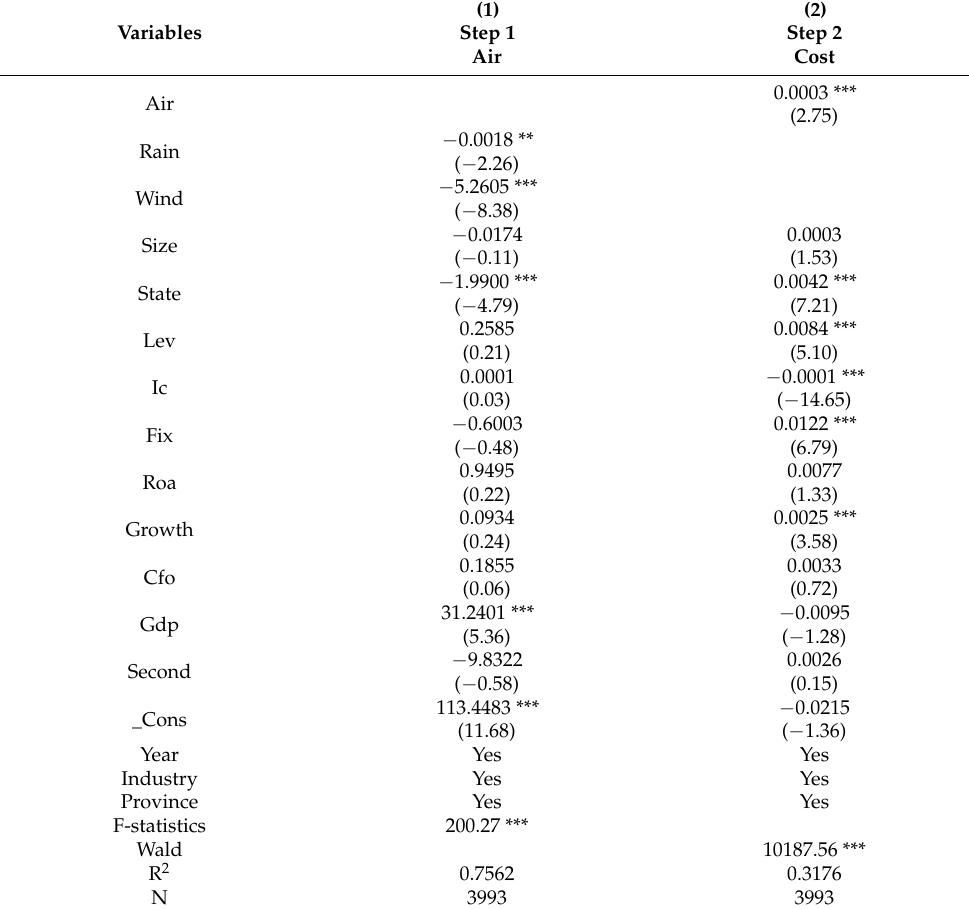
Table 9. Endogenous test of 2SLS